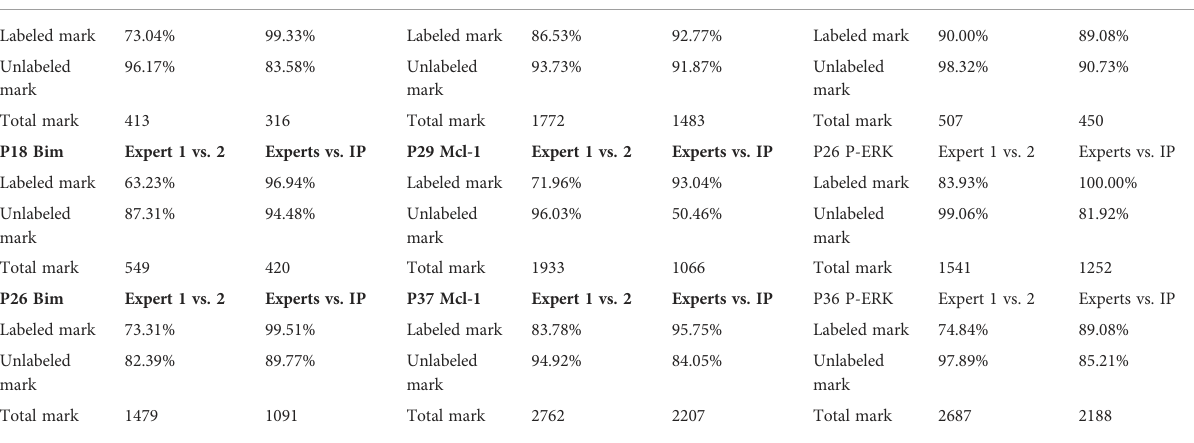
TABLE 1 Table of concordance of marks made on Stereology grids (one table/marker) by two experts (second column). P15 Bim